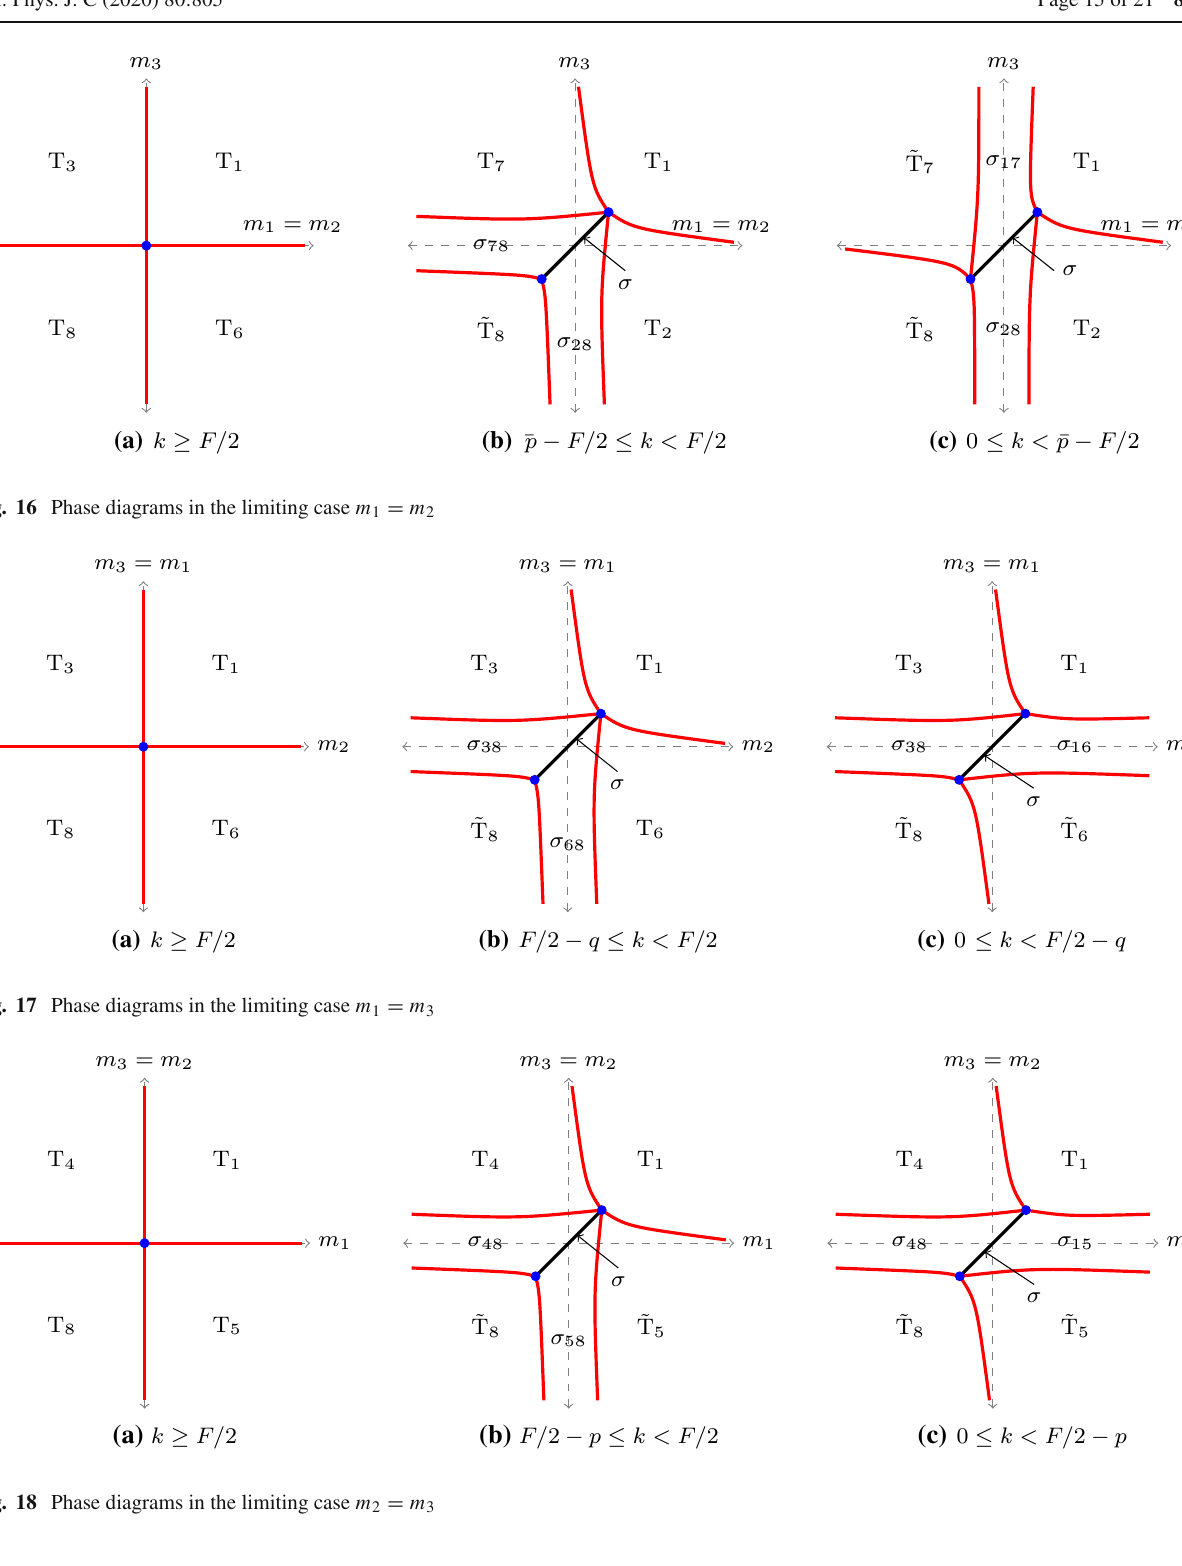
Fig. 16 Phase diagrams in the limiting case m 1 = m 2